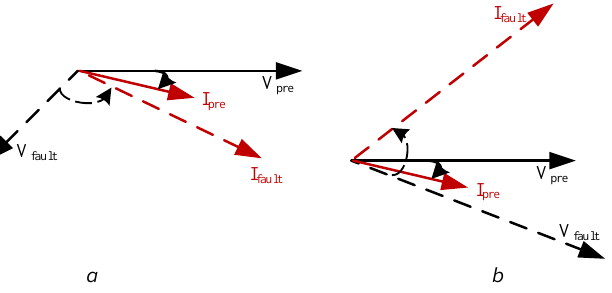
Figure 2. Phasor diagram for ( a ) voltage inversion ( b ) current inversion [8]. Voltage inversion occurs when the line becomes capacitive from the measurement point to the fault but remains inductive from the source to the fault point. This condition